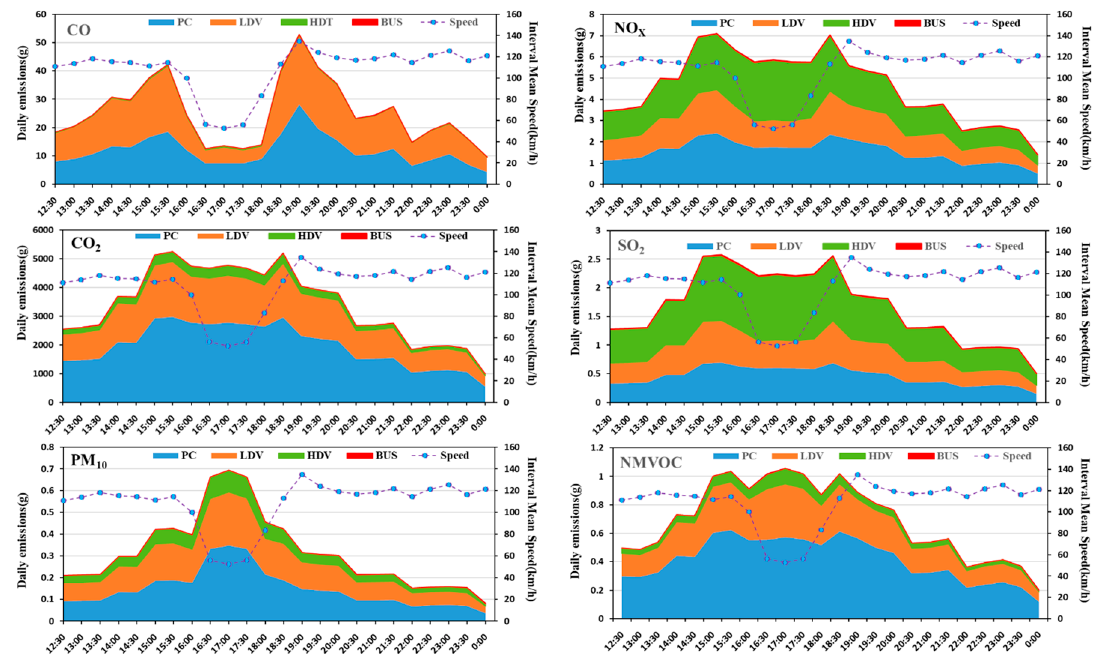
Figure 4. Daily vehicle emissions of different pollutants on Minnesota highway.